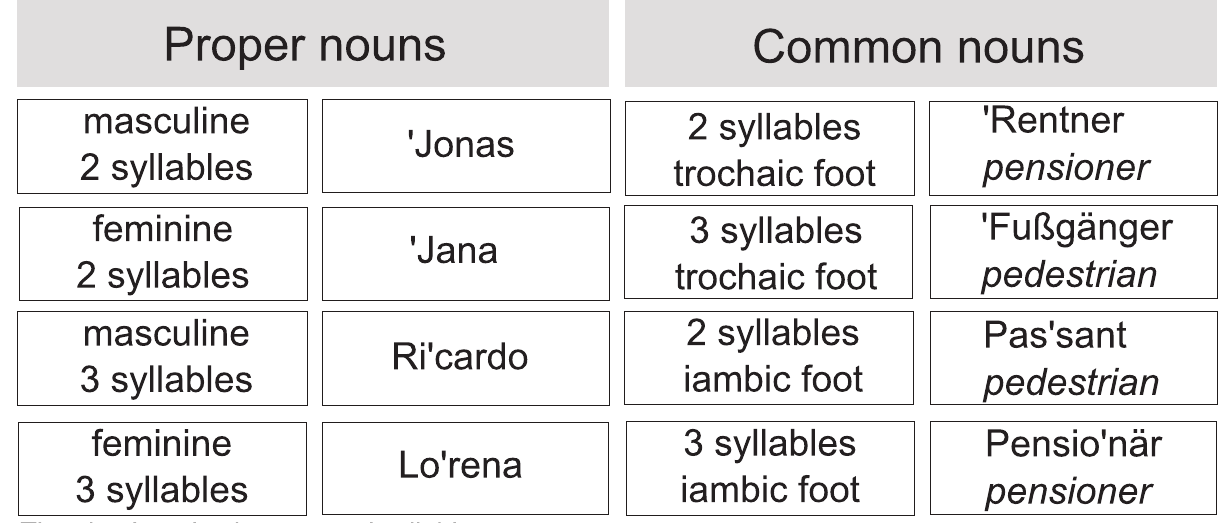
Figure 1. Examples of proper and common nouns used in the stimulus material.